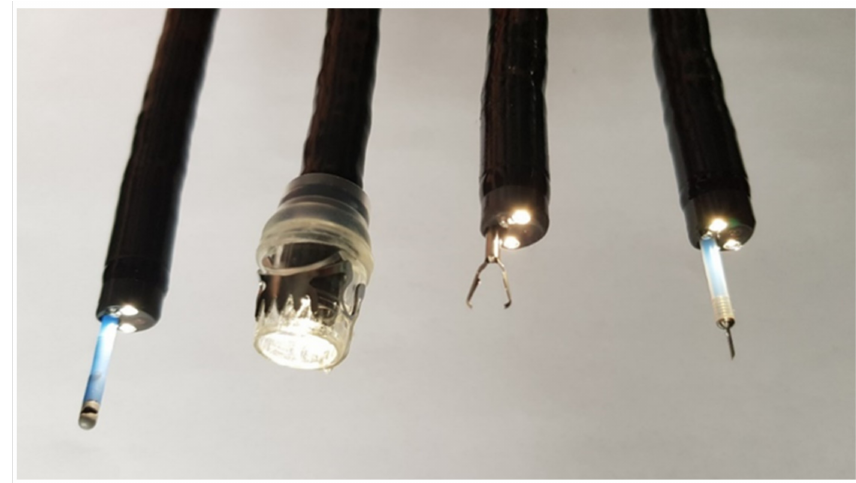
Figure 2. A selection of instruments for endoscopic haemostasis (from left to right): APC lateral probe, OTSC, TTSC haemostasis clip, injection needle. With kind permission from Dr. J. Fundel and U.